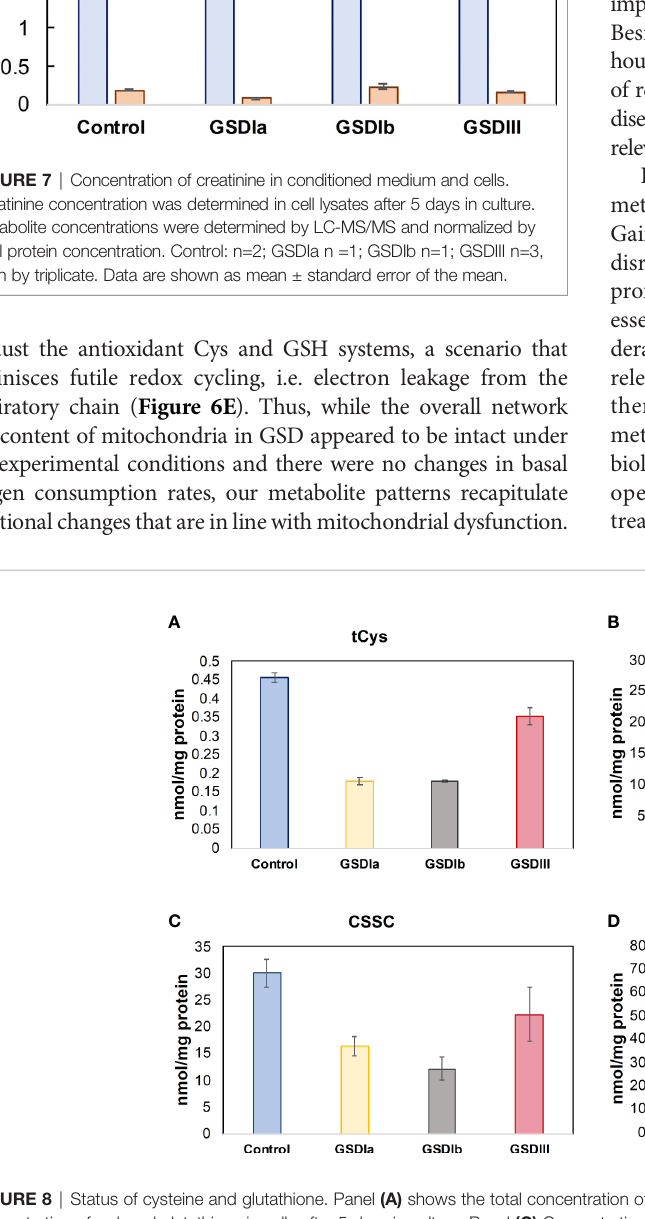
FIGURE 8 | Status of cysteine and glutathione. Panel (A) shows the total concentration of reduced cysteine in cells after 5 days in culture. Panel (B) shows the total concentration of reduced glutathione in cells after 5 days in culture. Panel (C) Concentration of oxidized cysteine in cells after 5 days in culture. Panel (D) Concentration of oxidized glutathione in cells after 5 days in culture. Metabolite concentrations were determined by LC-MS/MS and normalized by total protein concentration. Individual comparisons of healthy controls versus GSDIa, GSDIb, and GSDIII showed signi fi cantly reduced concentration of Cys and GSH in all GSD cells compared to healthy controls. A reduced concentration of CSSC was found in all GSD cell lines compared to healthy controls. In contrast, GSSG concentration was comparable to healthy controls in GSDIa and GSDIb, and signi fi cantly reduced in GSDIII. Control: n=2; GSDIa n =1; GSDIb n=1; GSDIII n=3, each by triplicate. Data are shown as mean ± standard error of the mean. Statistical signi fi cance for individual comparisons was assessed with one-way ANOVA, p